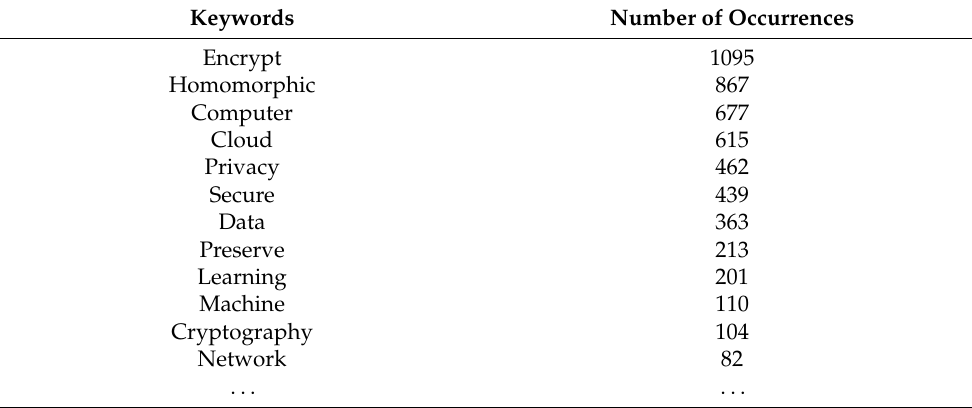
Table 7. Statistics of some keywords. Keywords